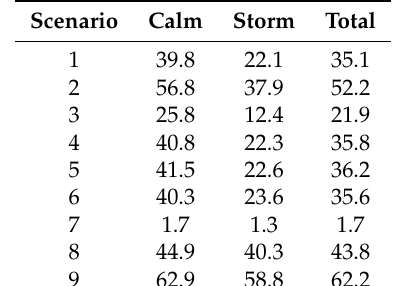
Table 4. Ripple-related roughness as a percentage of the total bedform-related roughness, averaged over the model domain excluding the basins, and averaged over time for the calm weather, storm and total modelling period.